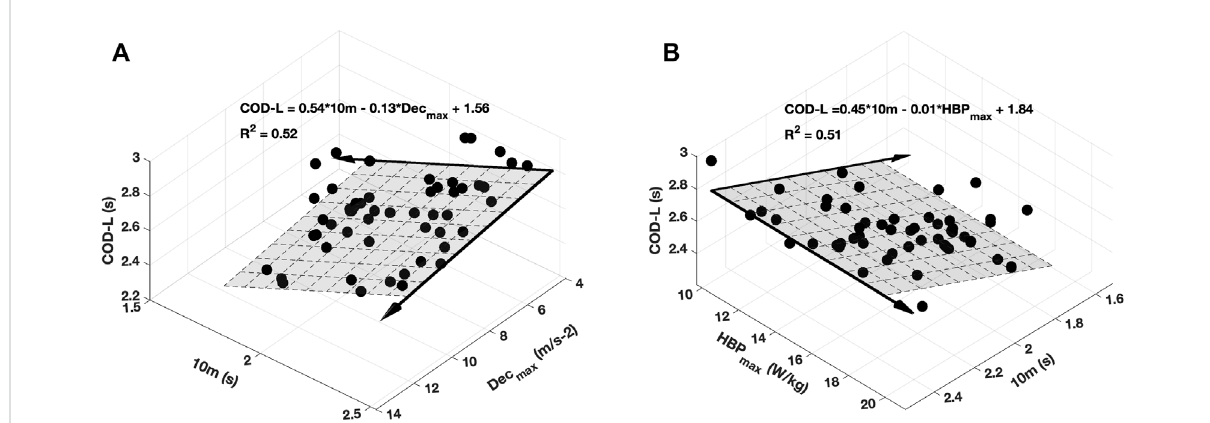
FIGURE 2 Acceleration and deceleration mechanicalparametersand COD performance on theleftside(COD_L) andrightside(COD_R)are displayed by COD performance (High vs. Low) in male soccer players; F0: maximal theoretical force; V0: maximal theoretical velocity; P max : maximal power; 10 m: 10 m split time; HBF max : maximum braking force; HBP max : maximum braking power; Dec max : maximum deceleration; *: p < 0.05; **: p < 0.01; ***: p < 0.001; ns: non-signi fi